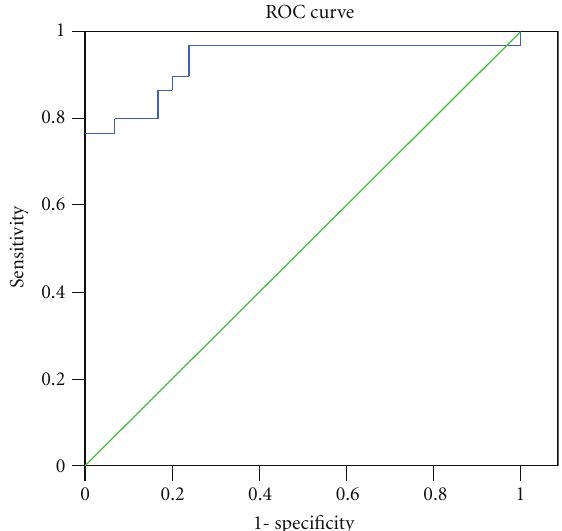
Figure 5: Receiver operating characteristic (ROC) curve of circu- lating immune complexes (CIC) for di ff erentiation between SLE patients and healthy control.